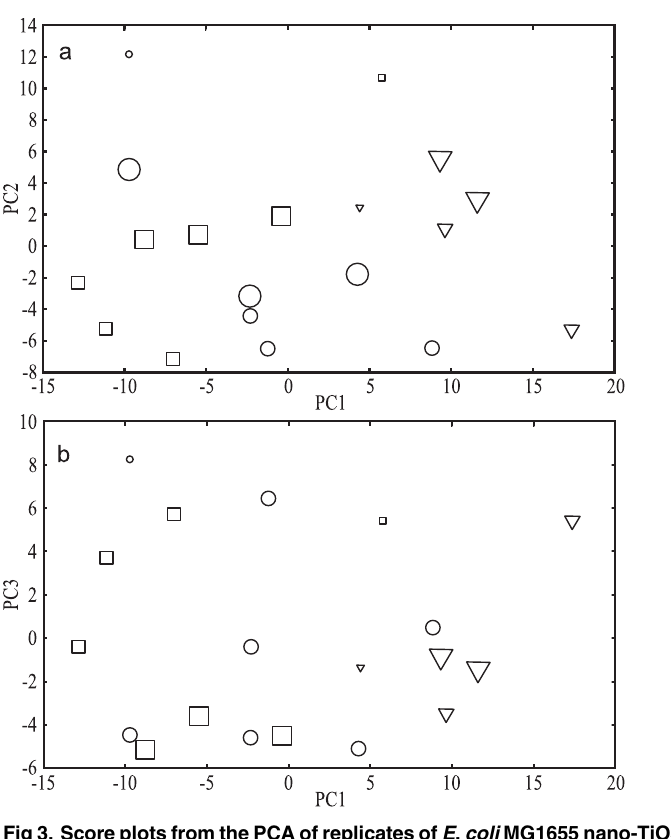
Fig 3. Score plots from the PCA of replicates of E . coli MG1655 nano-TiO 2 stressed according to the type of nano-TiO 2 and conditions of illumination with 100 ppm of nano-TiO 2 . R, P25 and control are codedin circles, squares and triangles, respectively.Room-light, 30 mW/cm 2 and 80 mW/cm 2 illumination are represented by small, averageand large symbols, respectively.(a) Principalcomponents2 vs . 1. (b) Principal components3 vs .